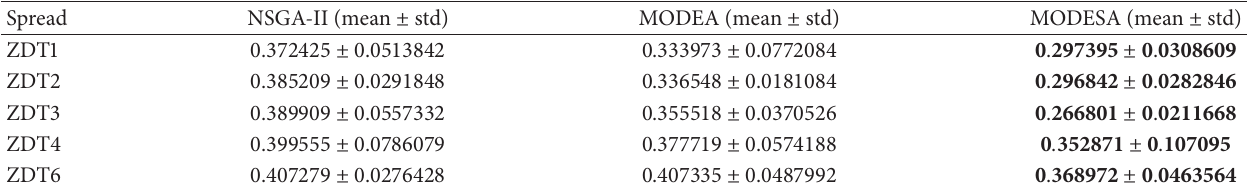
Table 3: The mean and standard deviation IGD-metric values of nondominated solutions in 10 runs on ZDTs where 𝑁 = 100 and 𝑇 = 250 . IGD NSGA-II (mean ± std) MODEA (mean ± std) MODESA (mean ± std) ZDT1 ZDT2 ZDT3 ZDT4 ZDT6 0.0137079 ± 0.00170579 Table 4: The mean and standard deviation Δ -metric values of nondominated solutions in 10 runs on ZDTs where 𝑁 = 100 and 𝑇 = 250 . Spread NSGA-II (mean ± std) MODEA (mean ± std) MODESA (mean ± std) ZDT1 0.372425 ± 0.0513842 0.333973 ± 0.0772084 0 . 297395 ± 0 . 0308609 ZDT2 0.385209 ± 0.0291848 0.336548 ± 0.0181084 0 . 296842 ± 0 . 0282846 ZDT3 0.389909 ± 0.0557332 0.355518 ± 0.0370526 0 . 266801 ± 0 . 0211668 ZDT4 0.399555 ± 0.0786079 0.377719 ± 0.0574188 0 . 352871 ± 0 . 107095 ZDT6 0.407279 ± 0.0276428 0.407335 ± 0.0487992 0 . 368972 ± 0 .